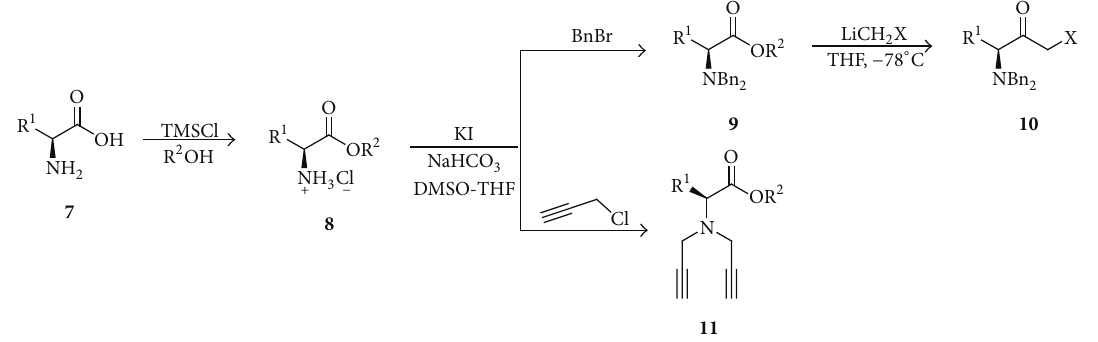
Scheme 2: Synthesis of starting compounds from 𝛼 -amino acids.